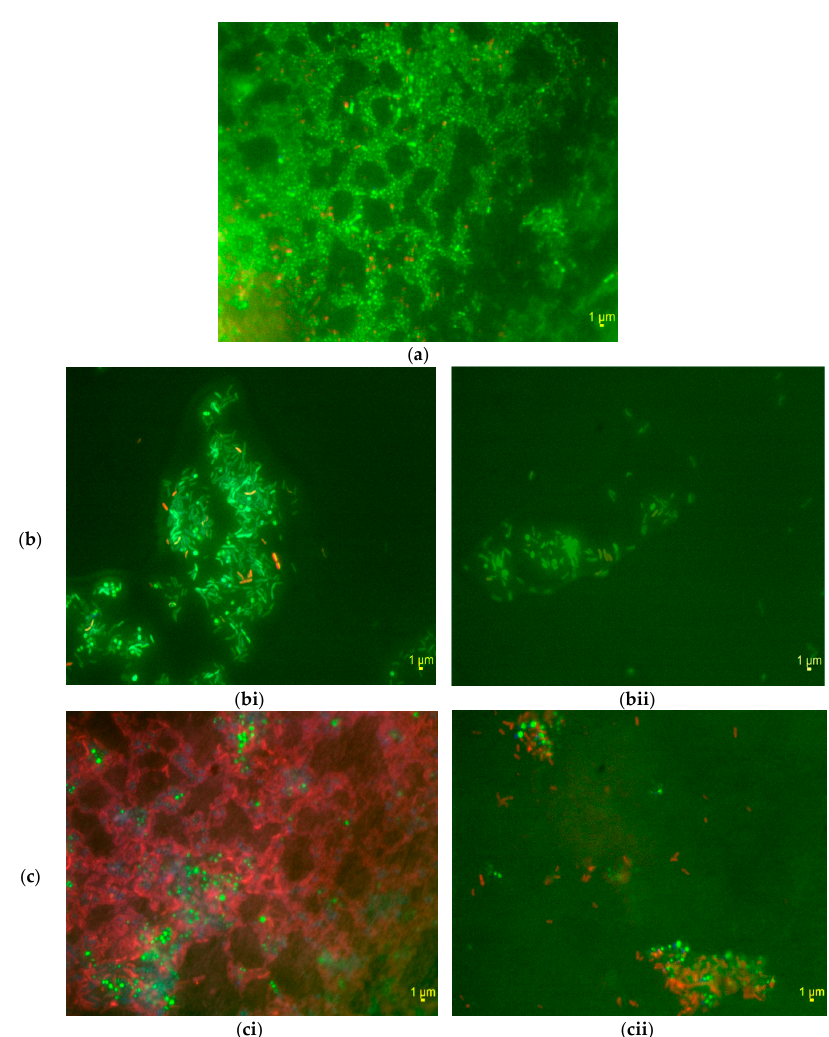
Figure 4. Fluorescence In Situ Hybridisation images: 1000× magnification of Methylobacterium and drinking water aggregates after 24 h. Methylobacterium DSM 18358: green; all drinking water bacteria: red; all DNA: blue. ( a ) Under stagnant conditions from the bulk water; ( b ) In laminar flow, ( bi ) from samples from the reactor slides and ( bii ) from samples from the bulk water; ( c ) In turbulent flow, ( ci ) from samples from the reactor slides and ( cii ) from samples from the bulk water.